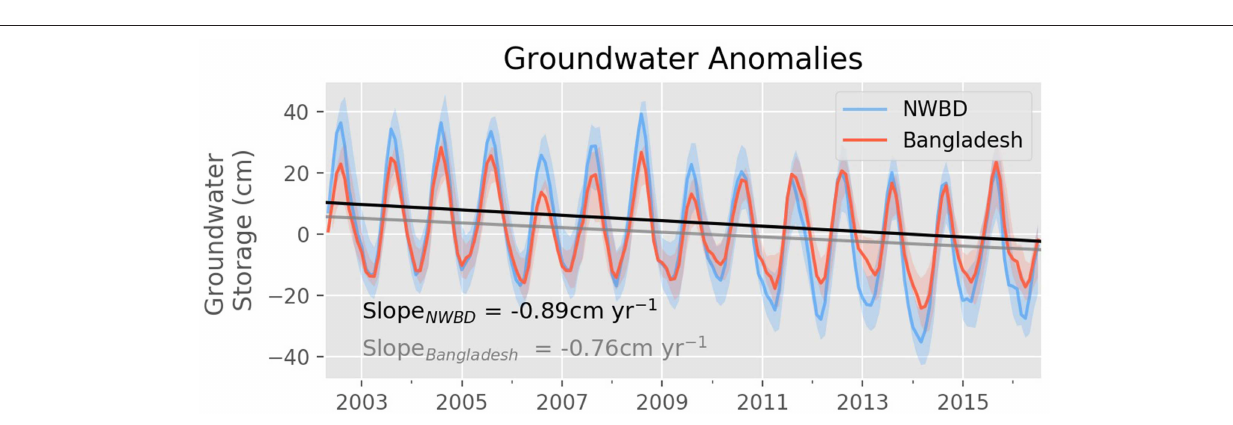
FIGURE 4 | Changes in groundwater anomalies for Bangladesh (red line) and Northwest Bangladesh (blue line). Slopes for Bangladesh (gray) and Northwest Bangladesh (black) show a decline in groundwater from 2002 to 2017. Shaded regions represent monthly groundwater uncertainty for each study region as computed by Equation